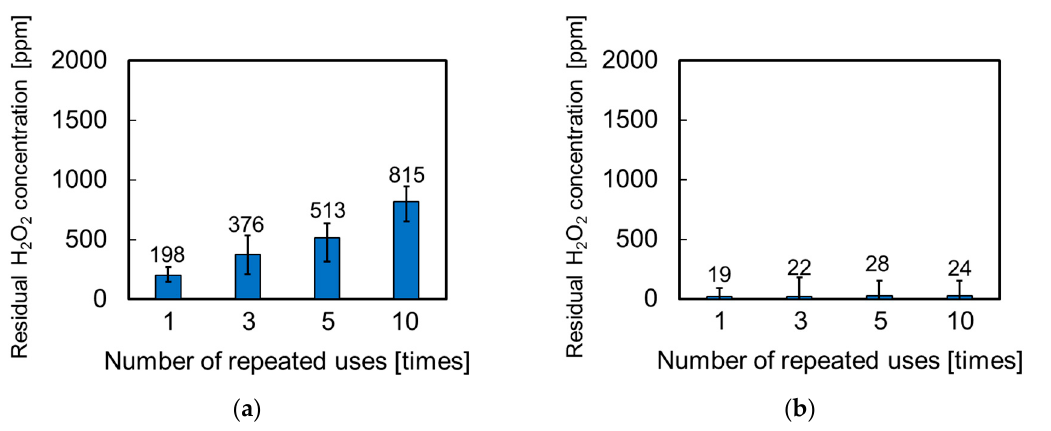
Figure 6. Catalytic durability of the ABS samples: relation between the number of use recycles and residual H 2 O 2 concentration in ( a ) Pt-particle/ABS and ( b ) Pt-film/ABS.